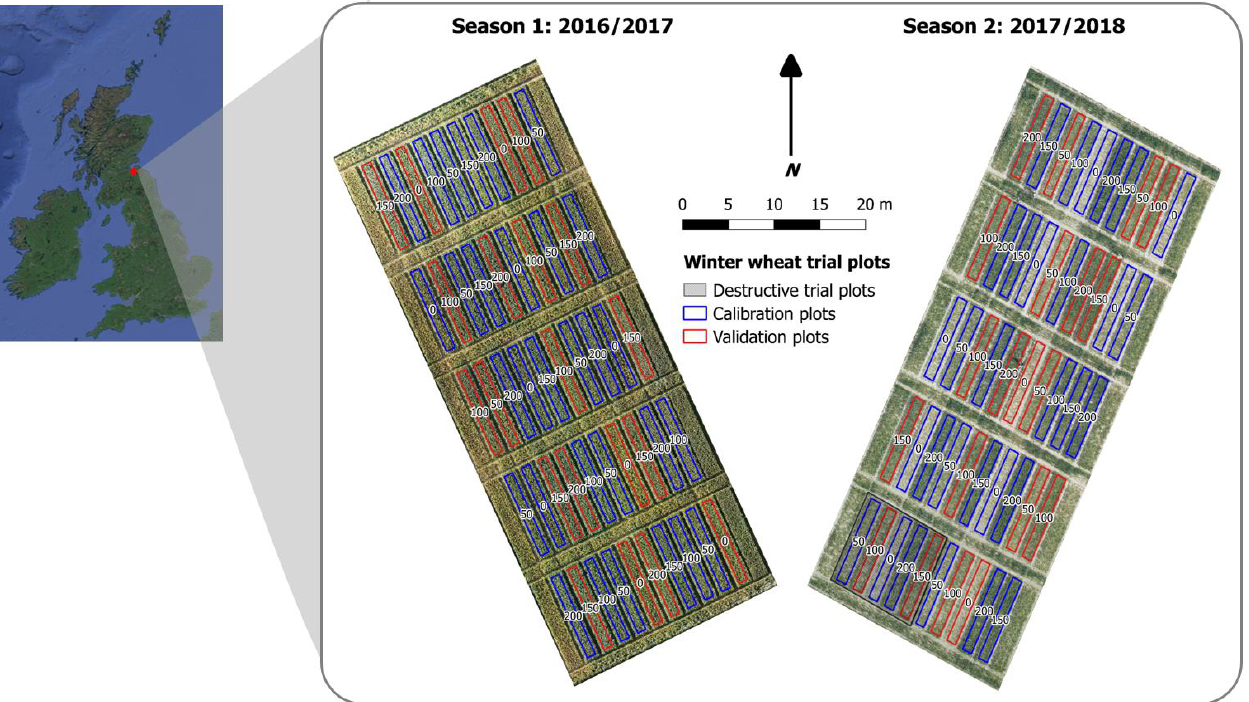
Figure 1. Winter wheat trial plot design used during growing season 1 (2016–2017) and season 2 (2017–2018) at different field locations. UAV-derived true-colour aerial images acquired during both seasons have annotations showing the nitrogen treatments (N; kg N ha −1 ) across 50 replicated trial plots along with plots selected for model calibration (blue) and validation (red). The locations of five plots used for the destructive sample analysis (season 2 only) are also highlighted (cross-hatching), whereas non-destructive canopy measurements were carried out at all 50 plots during both seasons. For both years, the N fertilization of plots was carried out as a split application — 50% of the total N was applied at growth stage (GS) 24 and the remainder was added at around